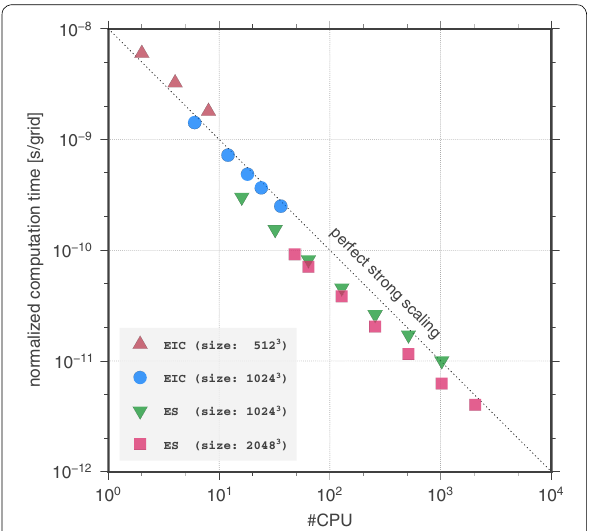
0.2 Fig. 8 Comparison of the normalized computation times between flat-MPI and OpenMP/MPI hybrid parallel computing. The experi- ments were conducted on the EIC computer (12 Cores/CPU) for the case of 1024 3 grids model with different number of